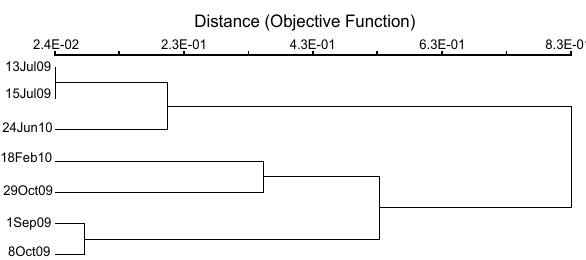
Fig. 5. Linkage diagram of seven rainwater samples including all m / z ’s detected with peak heights converted to presence/absence. The horizontal distance represents the objective distance